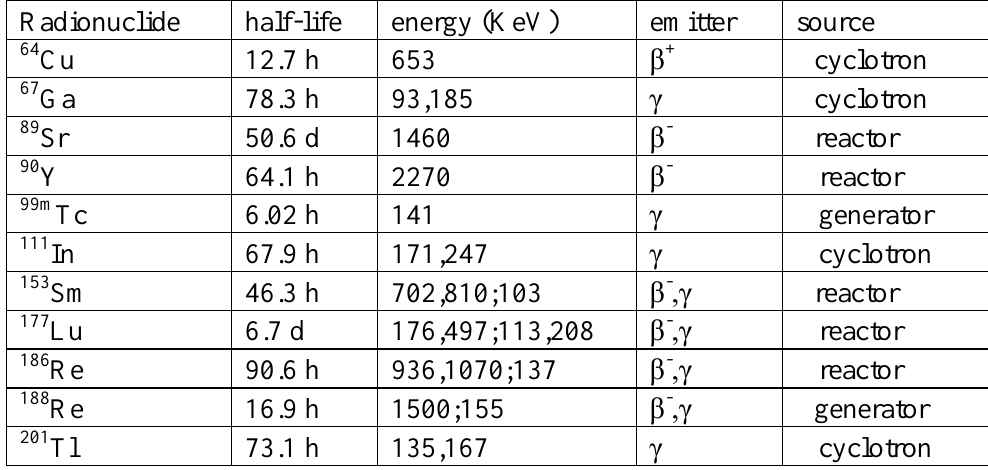
Table 1. Properties of selected metallic radionuclides useful in nuclear medicine.